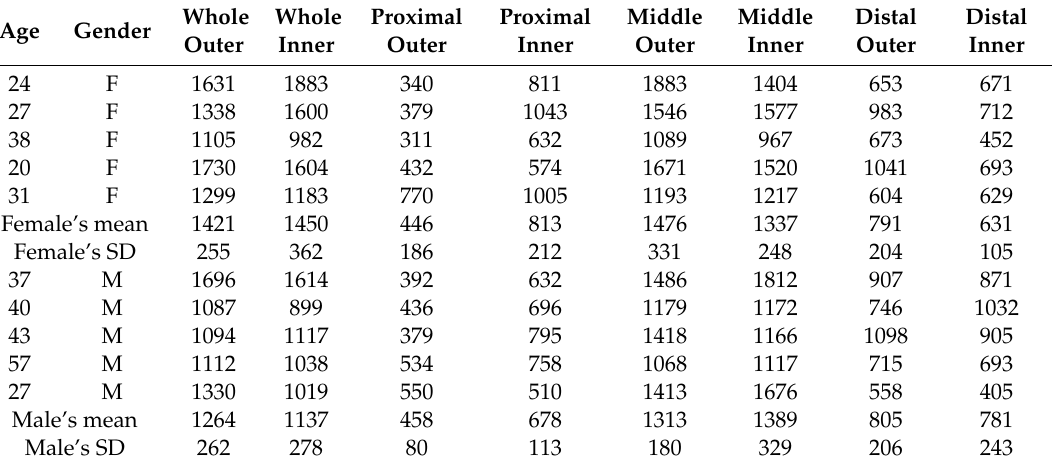
Table 1. General data (F: female. M: male). Units were mm.